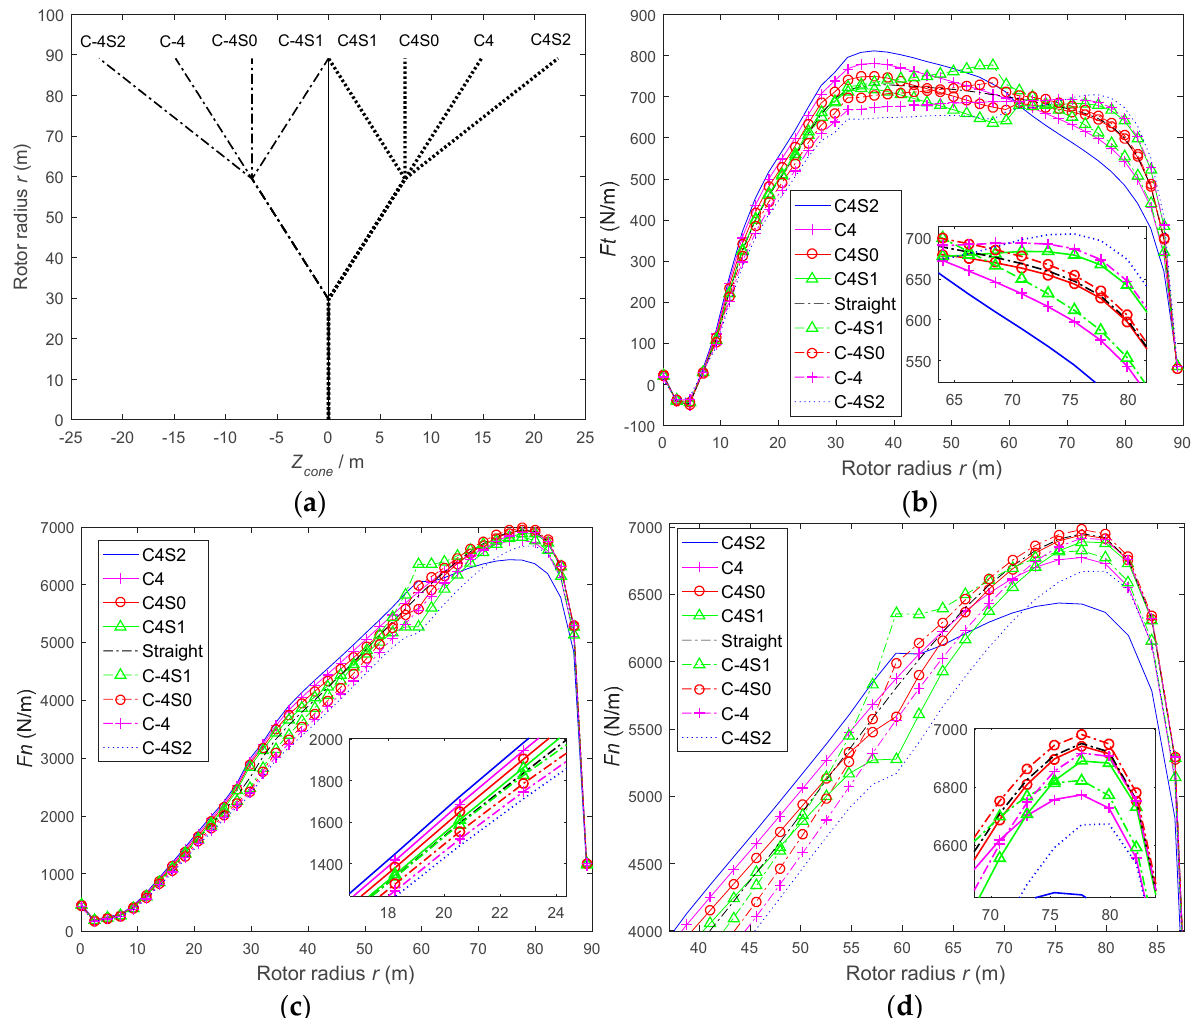
Figure 11. Comparison of special coning: ( a ) redrawn of special cone configurations; ( b ) tangential force; ( c ) axial force; ( d ) zoomed view of axial force.